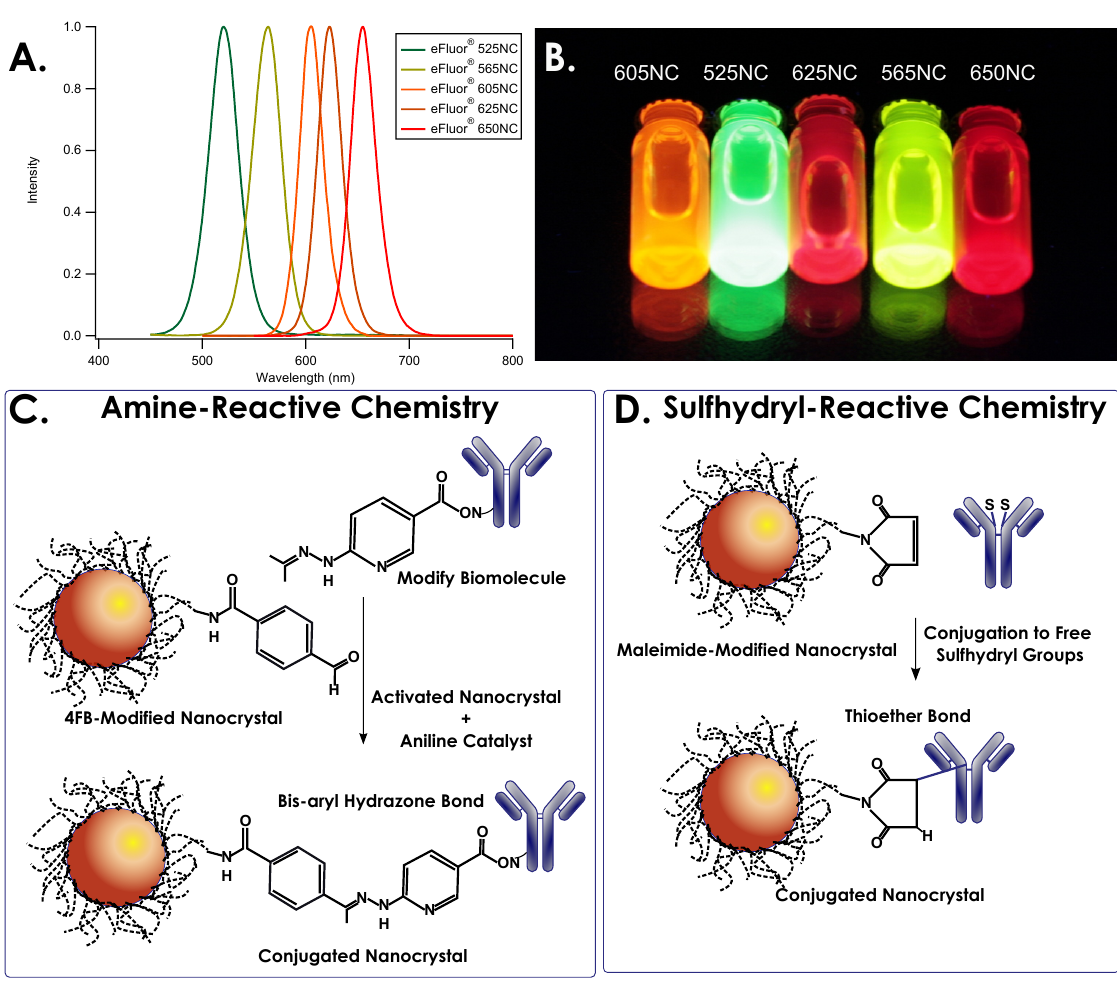
Figure 1. Illustration of conjugation reactions. ( A ) Emission spectra of all 5